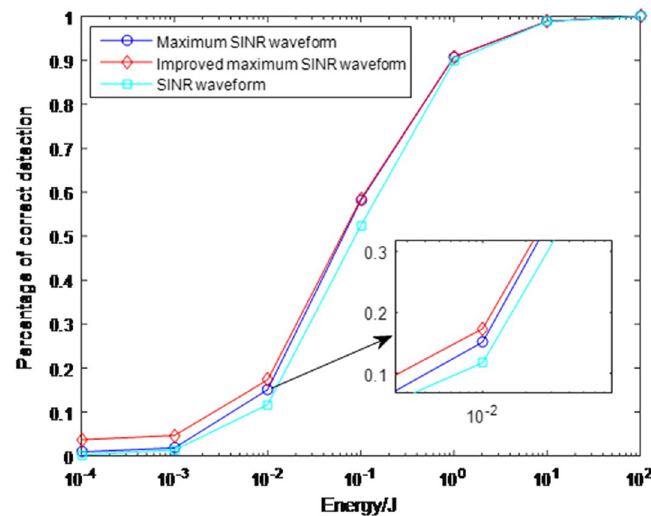
Fig. 14 Percentage of correct detection of different waveforms with maxmin strategy